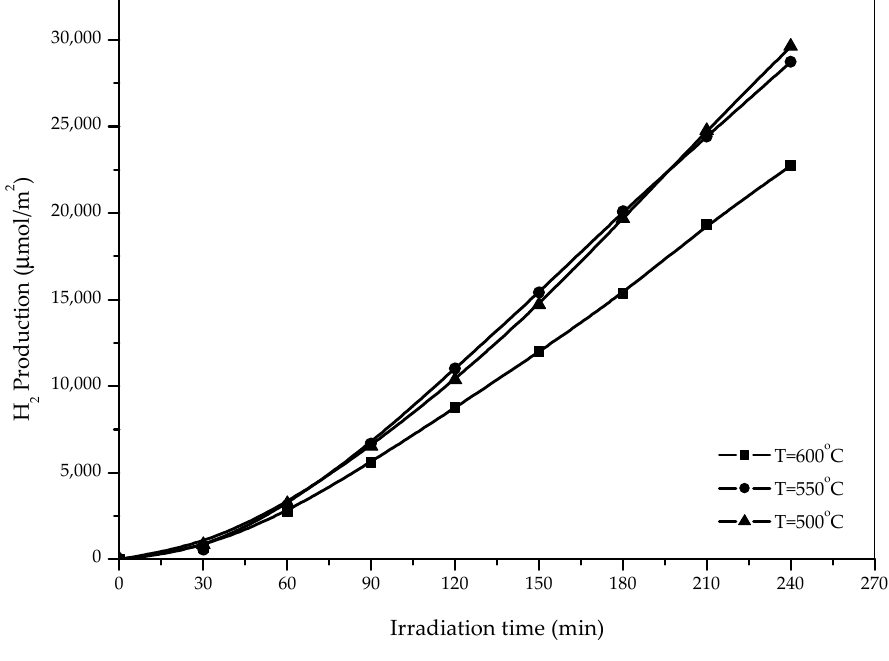
Figure 7. Effects of Temperature Annealing on the Production of H 2 from glycerol–water mixture (10%v glycerol).